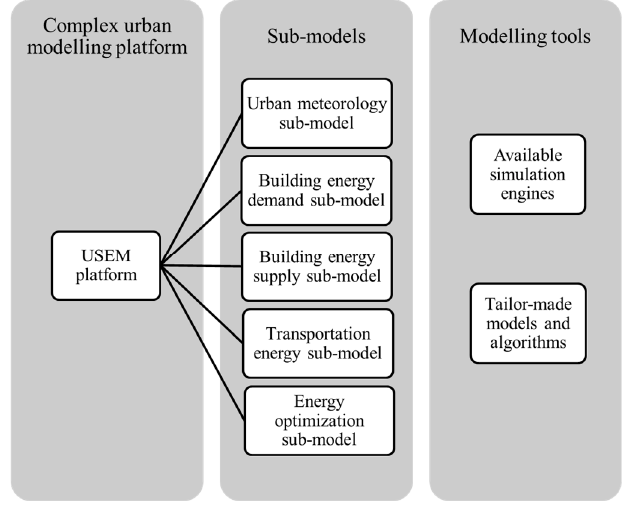
Figure 1. Sub-models in Urban-Scale Energy Modelling platforms.